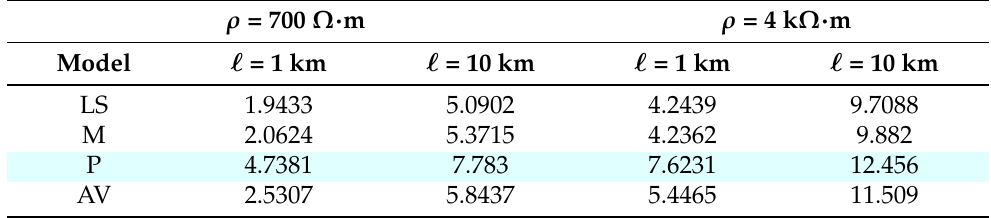
Table 11. δ ( % ) for the FD soil models (phases 2 and